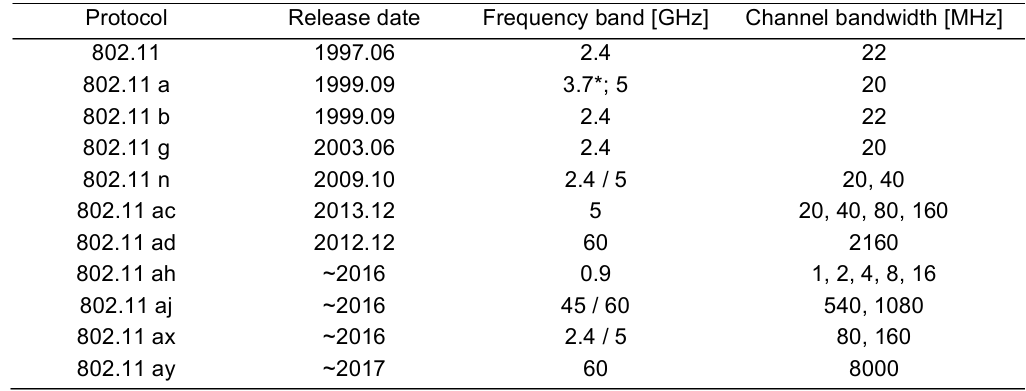
Table 3. IEEE802.11 spectrum bands breakdown for 802.11 protocol variants